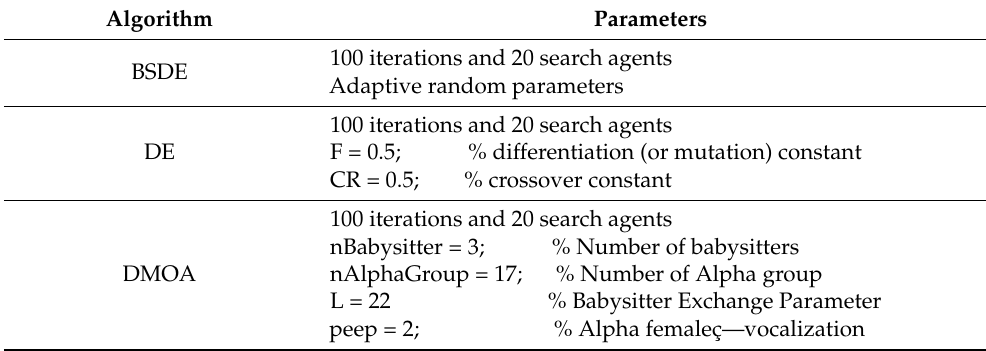
Table A1. Parameter settings of the employed algorithms for the optimal placement and sizing of D-SVC devices in distribution